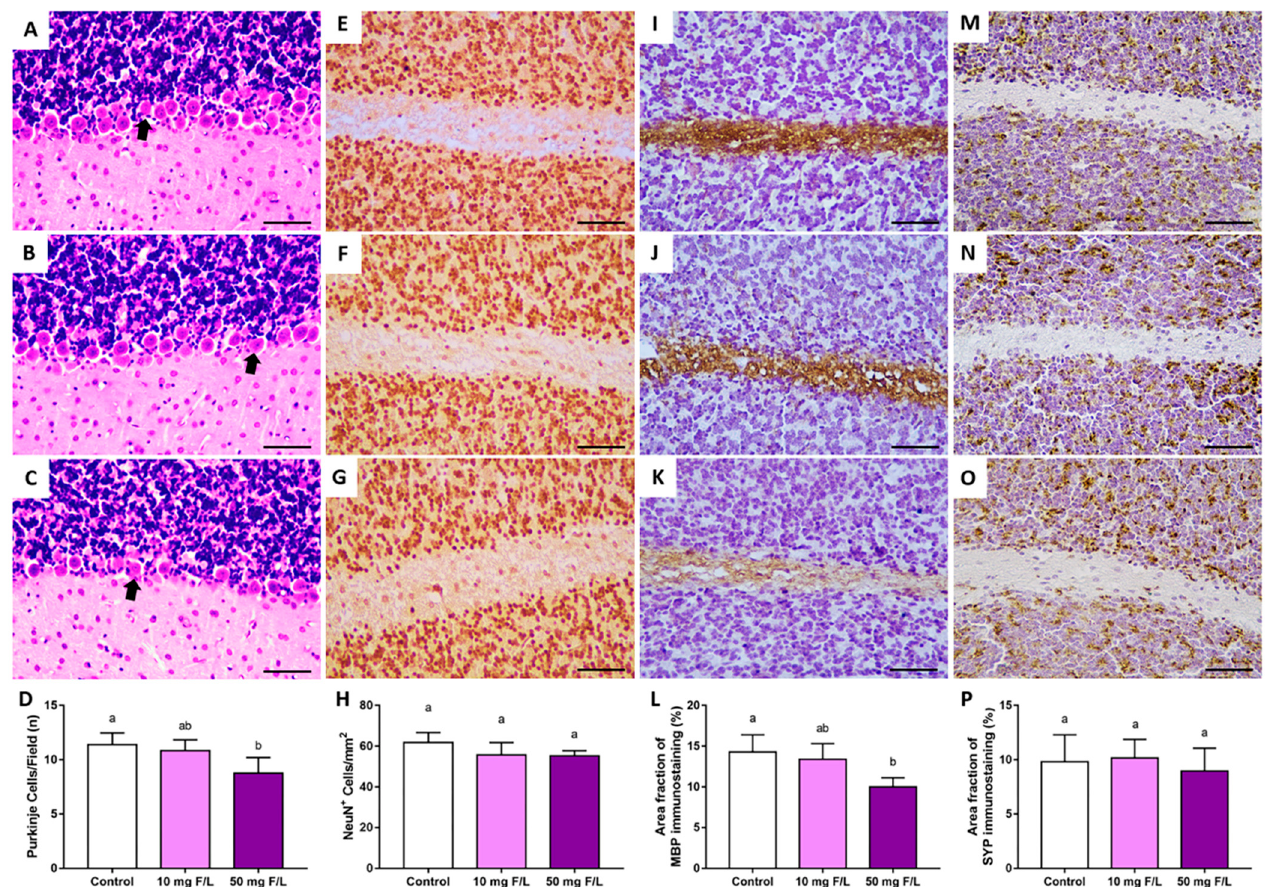
Figure 2. Effects on morphological aspects of the cerebellum of offspring after 42 days of fluoride exposure (10 mg F/L or 50 mg F/L, n = 5/group) during the gestational and lactation periods. Representative photomicrographs of sections stained in hematoxylin and eosin of the control ( A ), 10 mg F/L ( B ), and 50 mg F/L ( C ). Arrows indicate Purkinje cells. The results are expressed as the mean ± SEM of the number of Purkinje cells counted per field (one-way ANOVA and Tukey’s post hoc test, p < 0.05) ( D ). Representative photomicrographs of NeuN immunostaining (brown) sections of the control ( E ), 10 mg F/L ( F ), and 50 mg F/L ( G ). The results are expressed as the mean ± SEM of positive anti-NeuN cells counted per mm 2 (one-way ANOVA and Tukey’s post hoc test, p < 0.05) ( H ). Representative photomicrographs of myelin basic protein (MBP) immunostaining (brown) sections of the control ( I ), 10 mg F/L ( J ), and 50 mg F/L ( K ). The results are expressed as the mean ± SEM of the area fraction percentage of positive anti-MBP immunostaining (Kruskal–Wallis and Dunn’s post hoc test, p < 0.05) ( L ). Representative photomicrographs of synaptophysin (SYP) immunostaining (brown) sections of the control ( M ), 10 mg F/L ( N ), and 50 mg F/L ( O) . The results are expressed as the mean ± SEM of area fraction percentage of positive anti-SYP immunostaining (Kruskal–Wallis and Dunn’s post hoc test, p < 0.05) ( P ). Identical lowercase letters indicate the absence of a statistical difference. Scale bar = 5 µm.